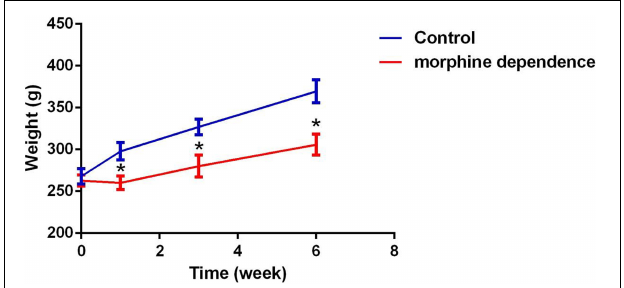
FIGURE 1 | Effect of different durations of morphine dependence on the body weight. Compared with the control group, morphine dependence significantly reduced the body weight gain of rats. The results are shown as mean ± SD, * P < 0.05 vs. control